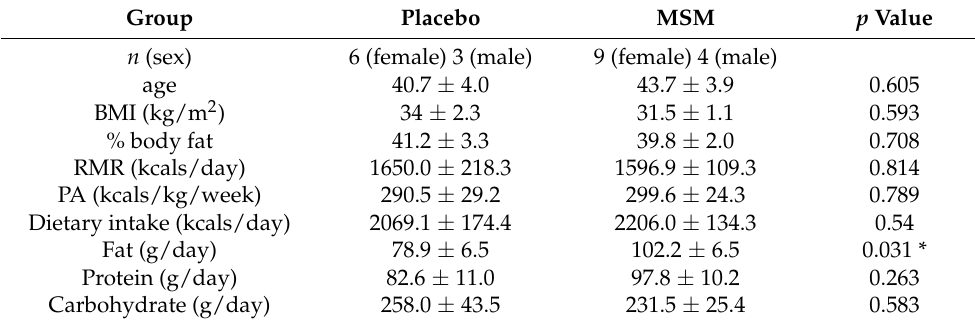
Table 1. Baseline